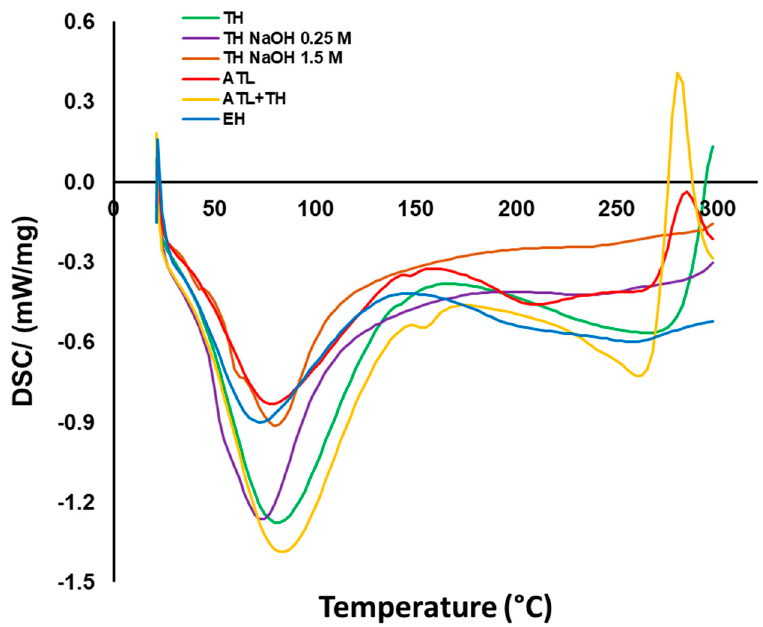
Figure 4. DSC curves resulting from heating the samples from 20 °C to 300 °C at a heating rate of 10 °C/min.